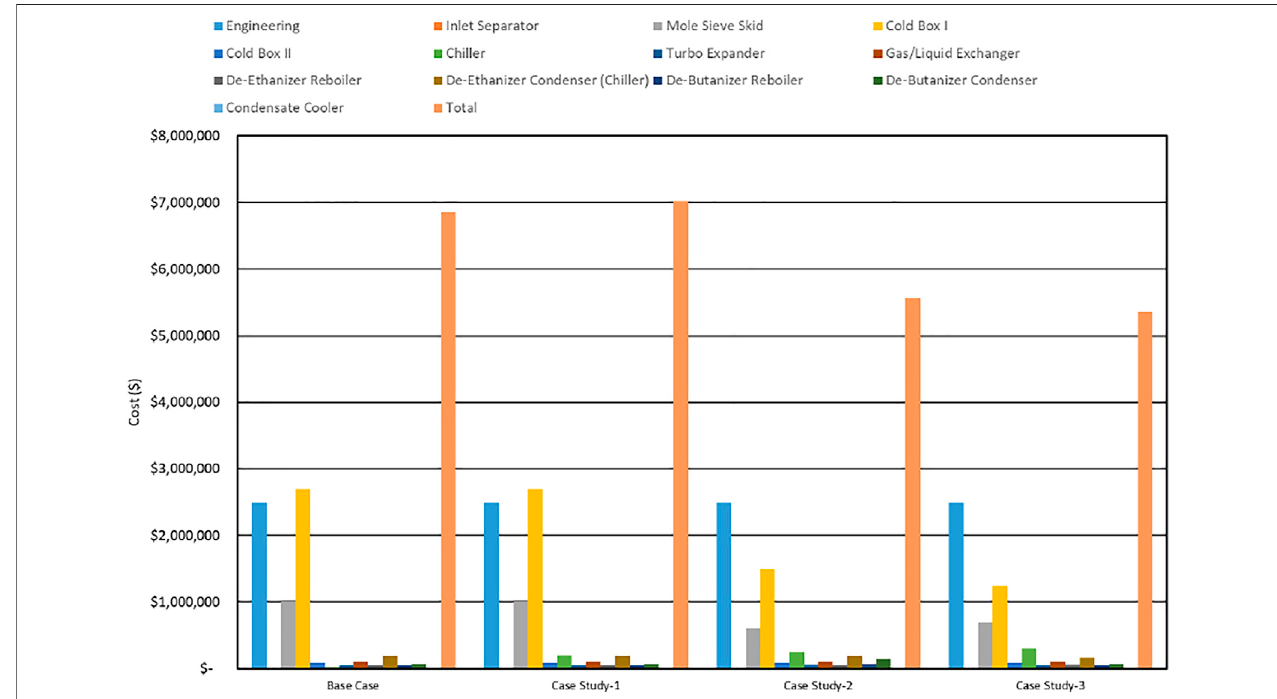
FIGURE 10 | Detailed cost of each unit for the base case and three case